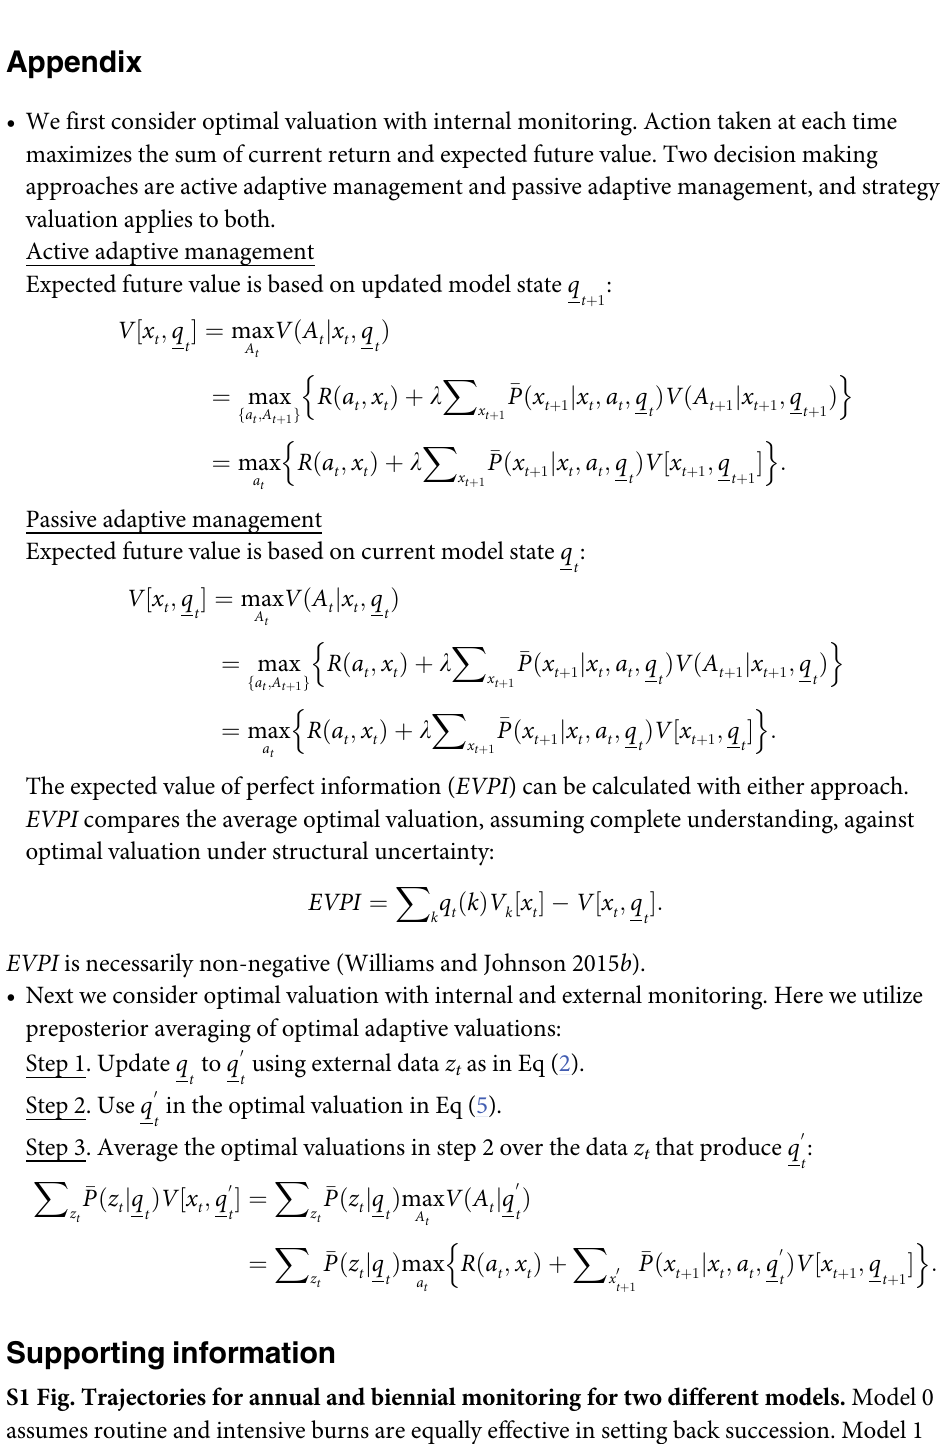
S1 Fig. Trajectories for annual and biennial monitoring for two different models. Model 0 assumes routine and intensive burns are equally effective in setting back succession. Model 1 assume intensive burn is more